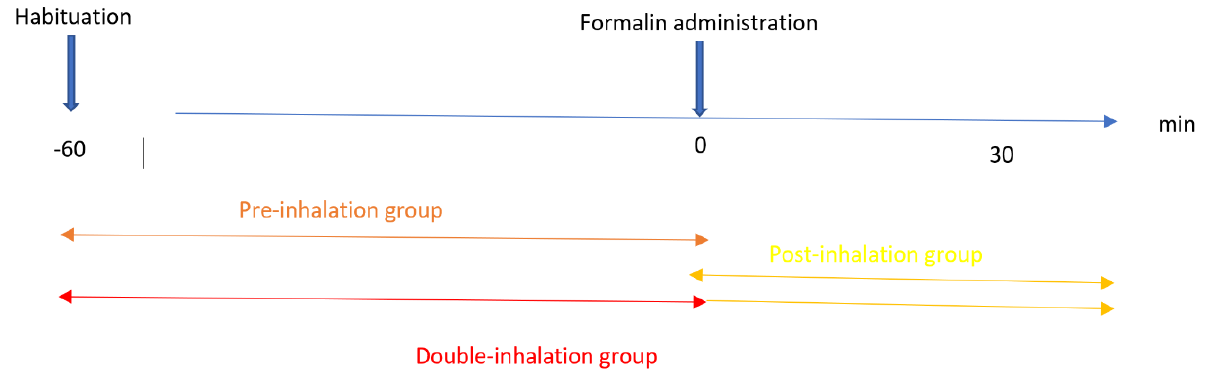
Figure 1. Protocol for bergamot essential oil (BEO) inhalation and that of its fractions with respect to the formalin test.